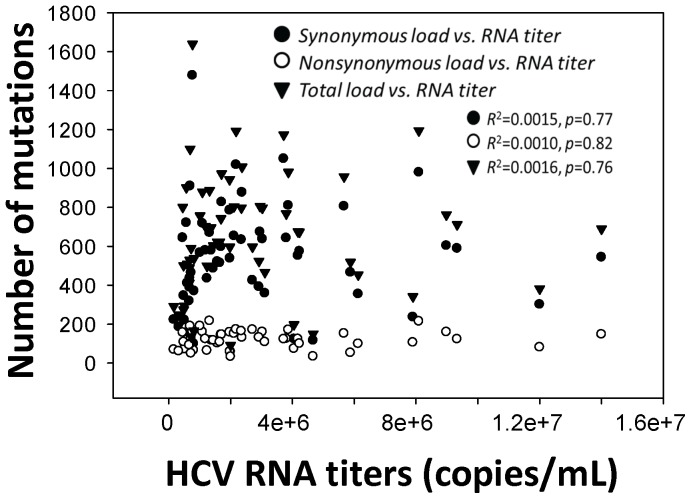
Lack of correlation between individual HCV RNA titers and mutation loads, including synonymous (R
2 = 0.0015, p = 0.77), nonsynonymous (R
2 = 0.001, p = 0.82) and the combination (R
2 = 0.0016, p = 0.76).